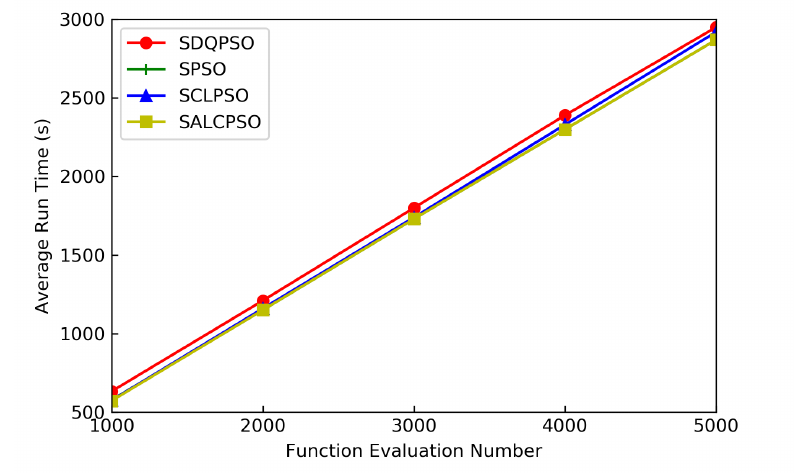
Figure 9. The running time under different function evaluations.